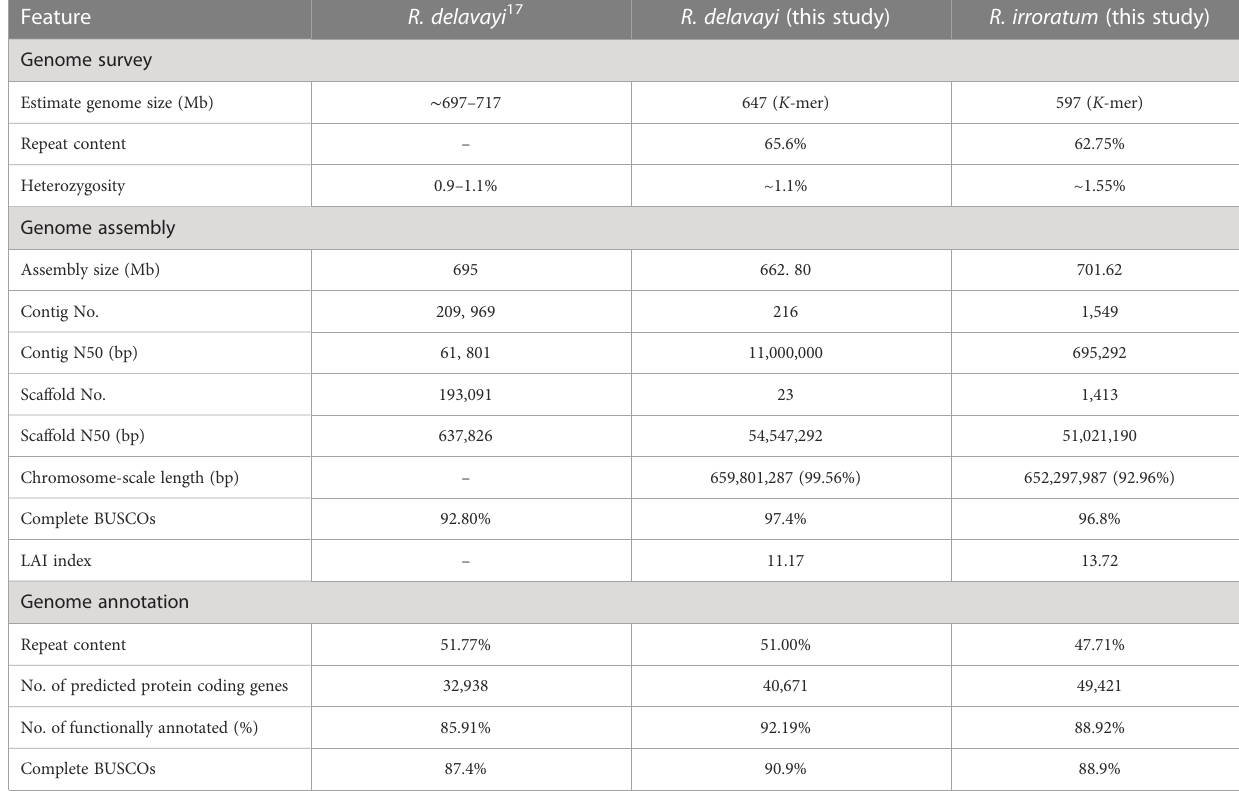
TABLE 1 Genome survey, nuclear genome assembly and annotation features of R. delavayi and R. irroratum.